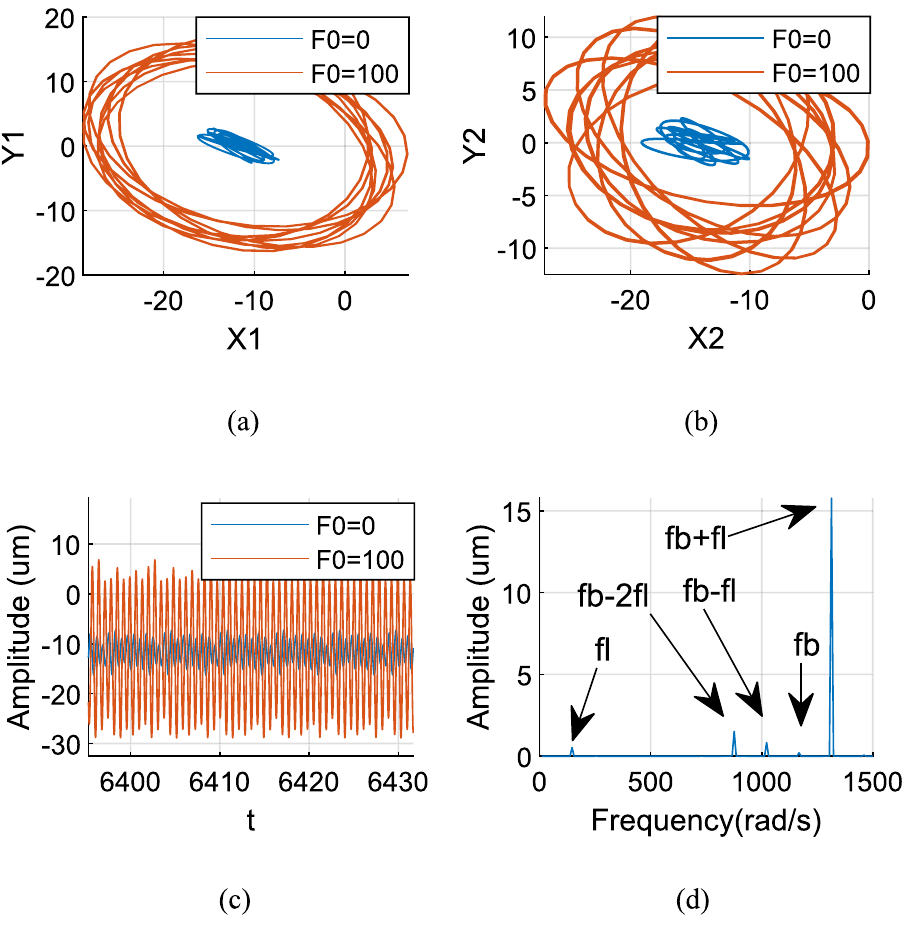
Figure 13. Aerodynamic resonance B of LP rotor (λ = 1. 75, ω l = 146 rad/s) (a) Orbit diagram of LP rotor (b) Orbit diagram of HP rotor (c) Time history (d) Frequency